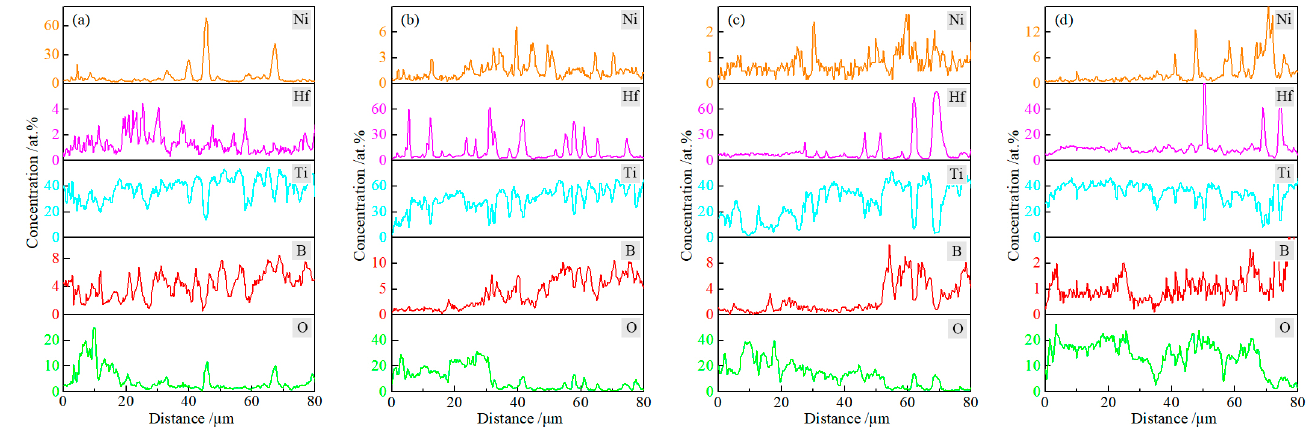
Figure 9. Line EDS results of cross-section of TBHB at 1100 °C in different oxidation times: ( a ) 1 h, ( b ) 4 h, ( c ) 7 h, ( d ) 10 h.